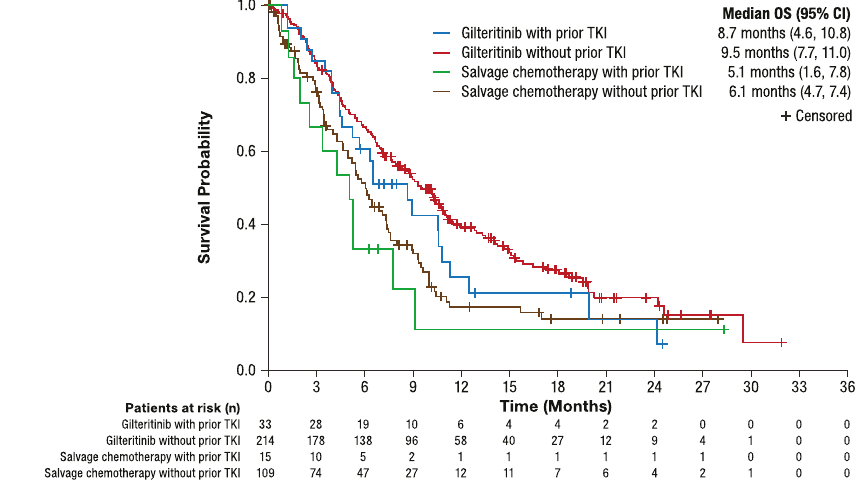
Fig. 2 Overall survival by prior TKI status in patients with FLT3 -mutated R/R AML: ADMIRAL trial. AML acute myeloid leukemia, CI con fi dence interval, OS overall survival, R/R relapsed or refractory, TKI tyrosine kinase